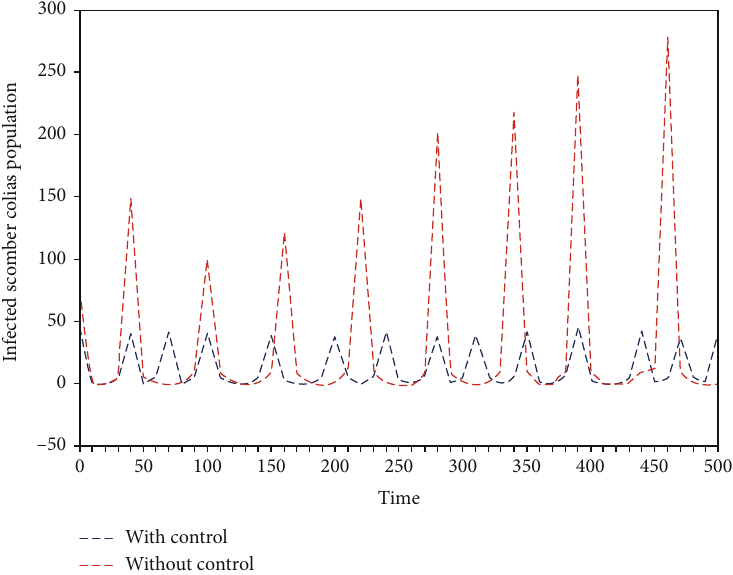
Figure 11: Infected Scomber colias population with optimal harvesting and e ff ort harvesting, with medium e ff